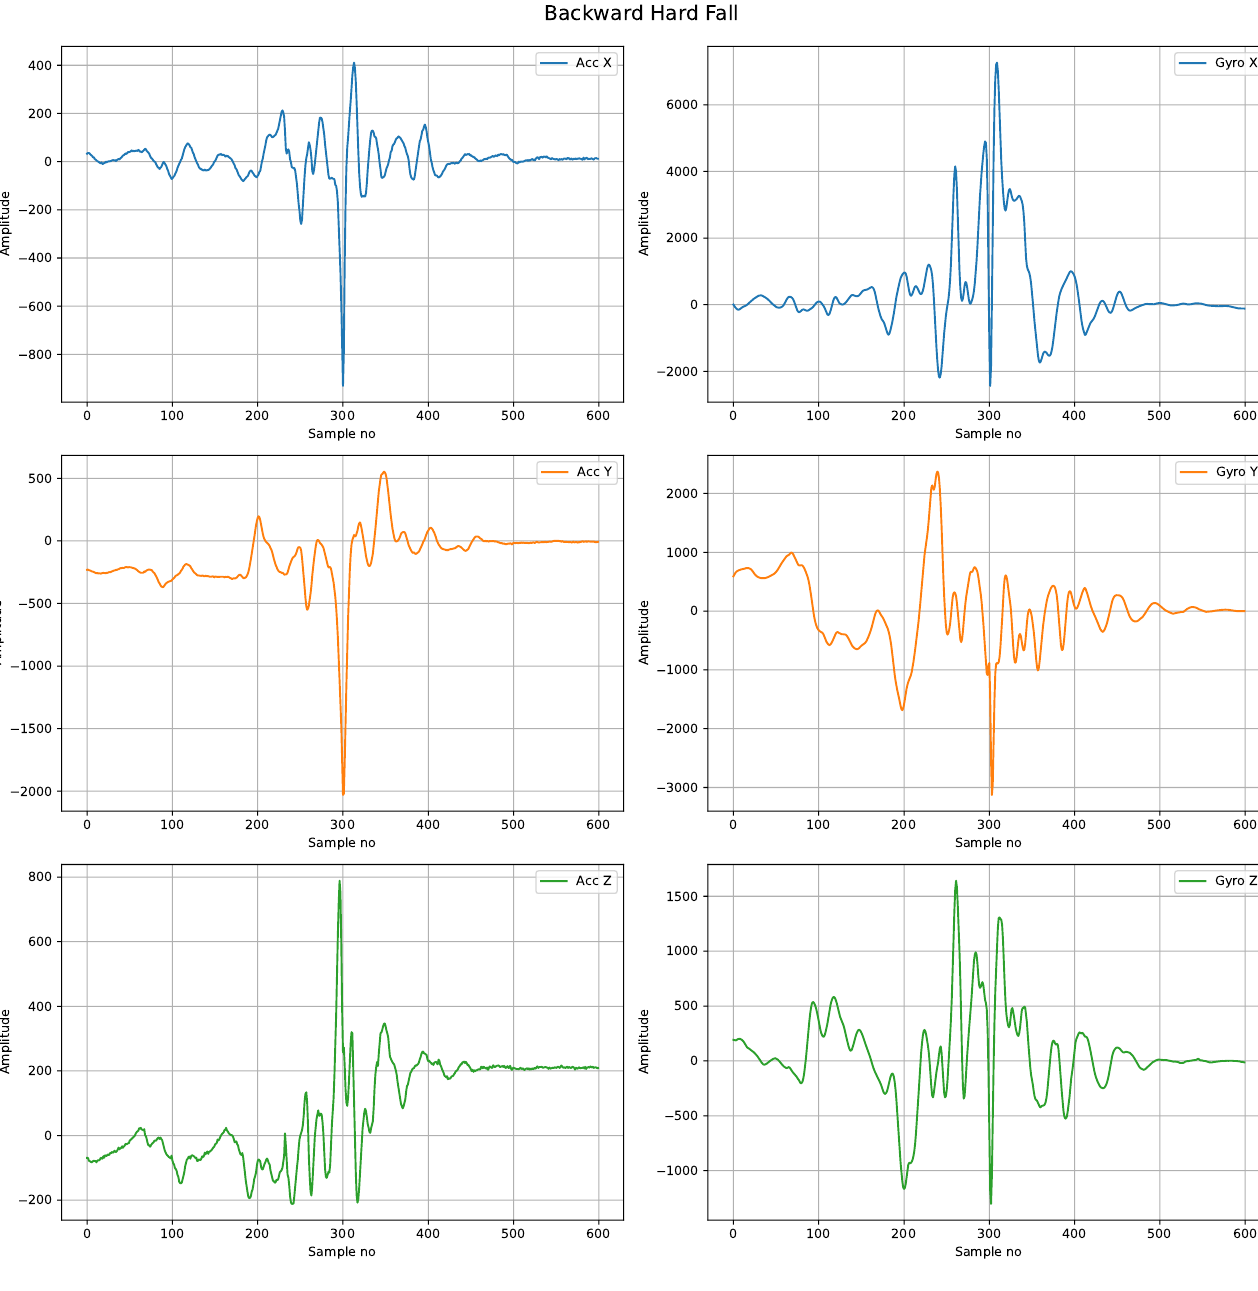
Figure A3. Accelerometer and gyroscope measurements: backward hard